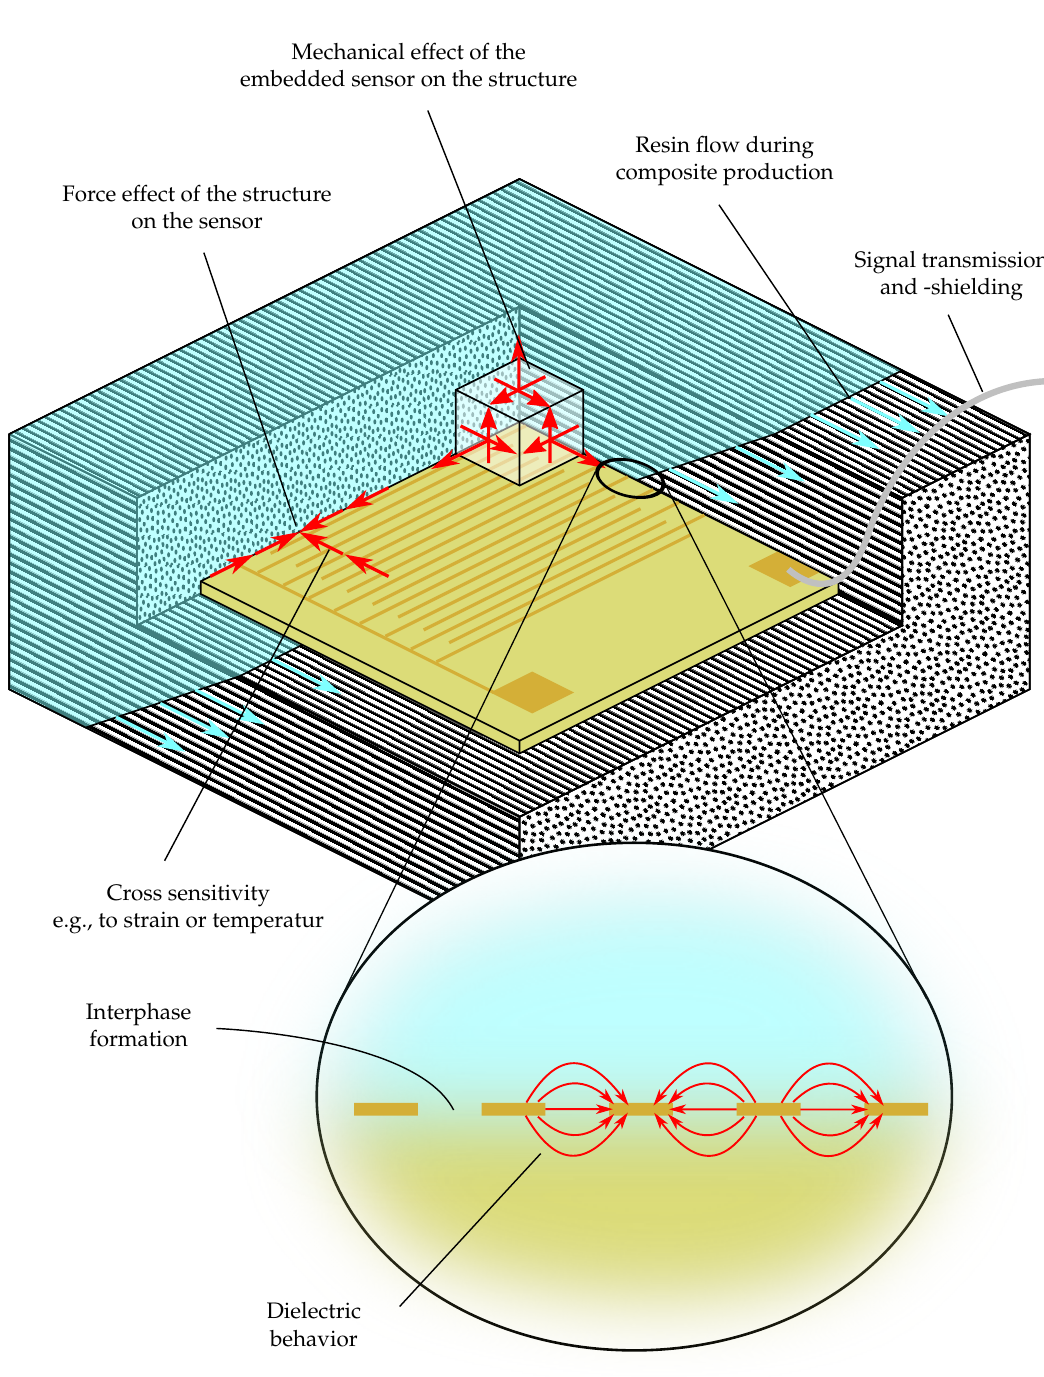
Figure 1. Questions arising from the integration of film